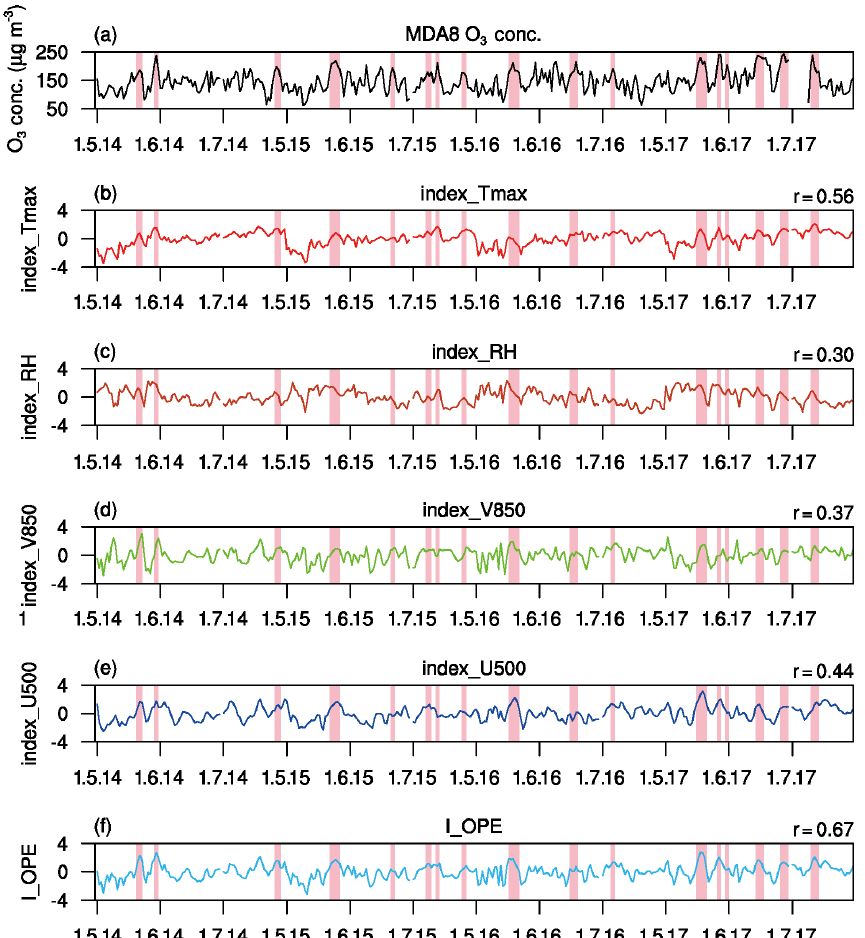
Figure 6. Daily variations in (a) MDA8 O 3 concentrations (µgm − 3 ) in North China, (b) index_Tmax, (c) index_RH, (d) index_V850, (e) index_U500 and (f) I_OPE for the months of May to July of 2014–2017. Observed OPEs in North China are highlighted by pink rectangles. Correlation coefficients between MDA8 O 3 concentrations and different indexes are shown above the top right corner of each